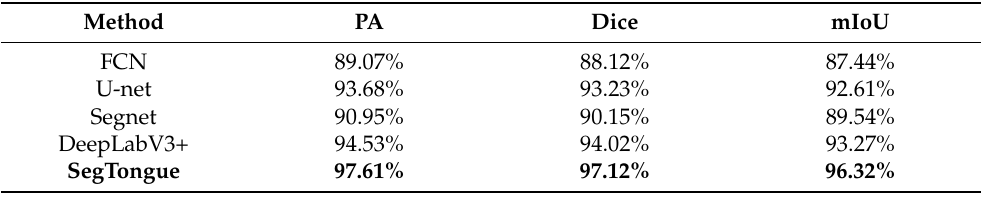
Table 1. Segmentation performance of different methods.